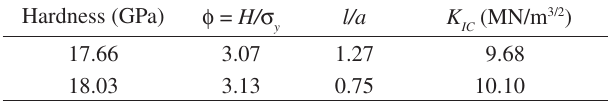
Table 3. Fracture toughness of WC-6Co calculated from the indentation testing results.